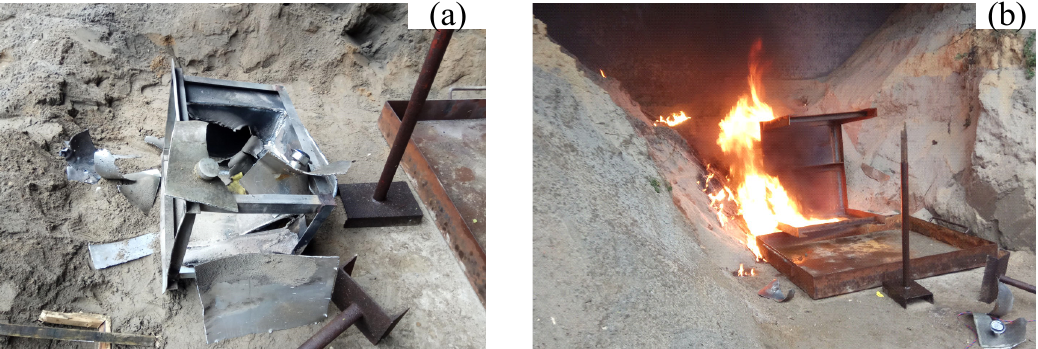
Figure 7. High-speed video frames of the fuel tank damaged by the 35 g steel fragments (v = 2298 m/s).